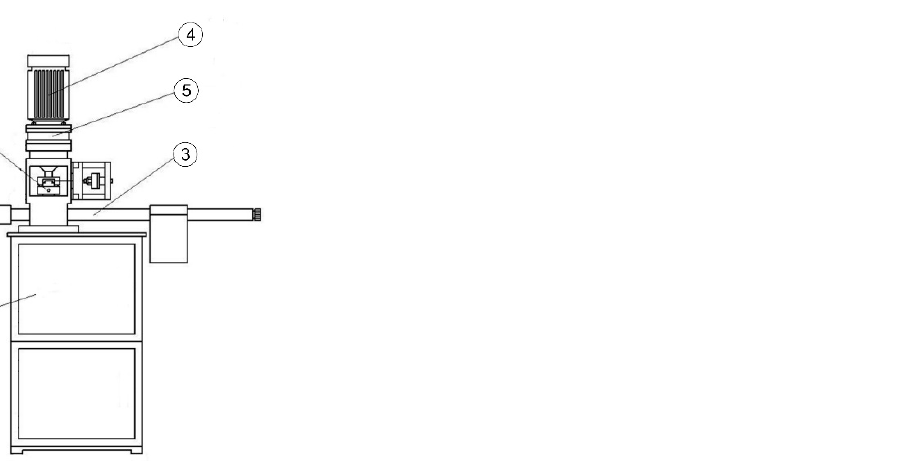
Figure 2. Four-ball machine T-02U [53]; 1, base; 2, ball holder; 3, loading unit of tribosystem; 4, drive unit; 5, body.